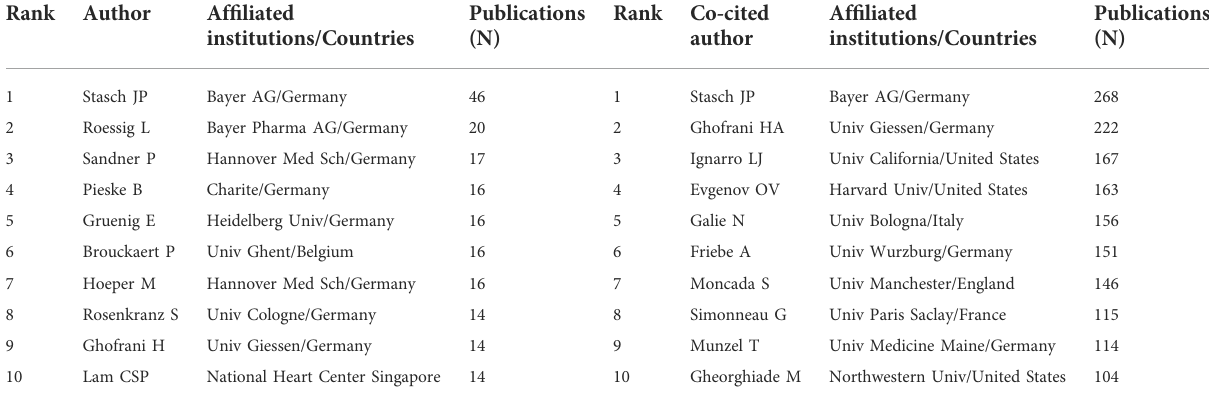
TABLE 4 Top 10 productive authors and co-cited authors in cardiovascular research of sGC stimulators.